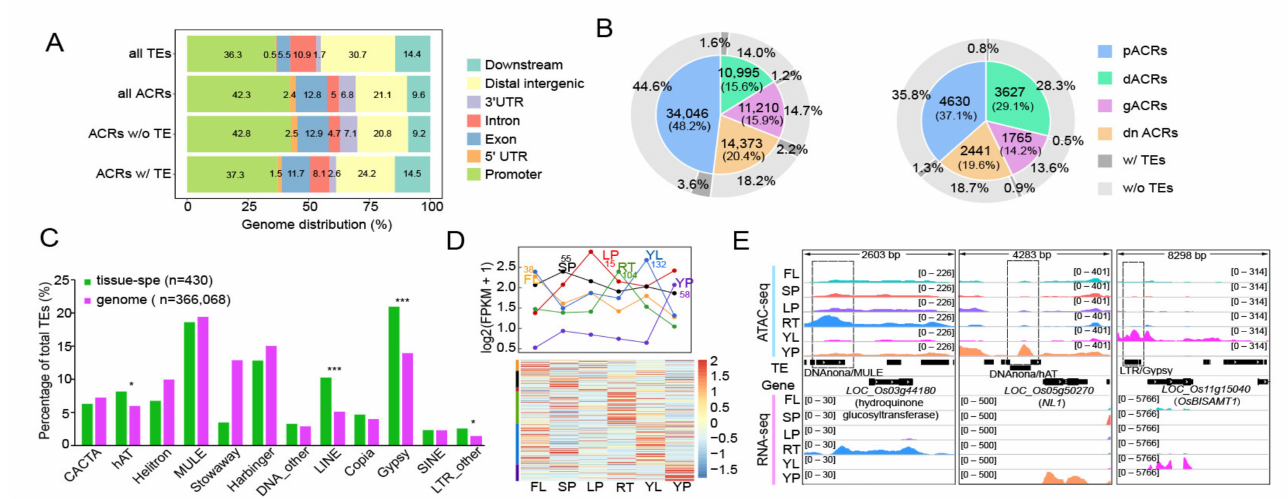
Figure 3. The association between TE-derived tissue-specific ACRs and tissue-specific gene expres- sion.( A ) Sub-genomic distributions of all TEs, all ACRs, ACRs without ( w / o ) TE and ACRs with ( w /) TEs, including promoters (upstream 2 kb), exons, introns, downstream (2 kb) and distal intergenic regions. ( B ) Pie plot showing the ratio of different types of common ( left ) and tissue-specific ACRs ( right ) based on their distances to the nearest genes, 8.6% and 3.5% of these ACRs were TE-derived ACRs (>50% ACRs length covered by TE sequences), respectively. ( C ) Bar plot illustrating the percentage of TE superfamilies associated with tissue-specific ACRs and the percentage of TE super- families in the whole genome, significance test was determined using hypergeometric test, * p < 0.05, *** p < 0.001. ( D ) The expression pattern of the nearest genes of TE-derived tissue-specific ACRs, the lineplot (upper) showing the mean expression levels of genes in each tissue, each row in the heatmap (bottom) represents a gene expression variation in six tissue types, the color represents gene expression levels. The number represents the amount of genes in each tissue. ( E ) IGV snapshots showing expressed tissue-specific genes with tissue-specific TE-derived